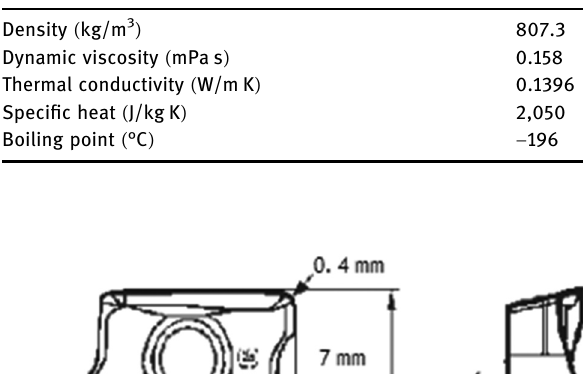
Table 3: Properties of LN 2 [ 25 ]